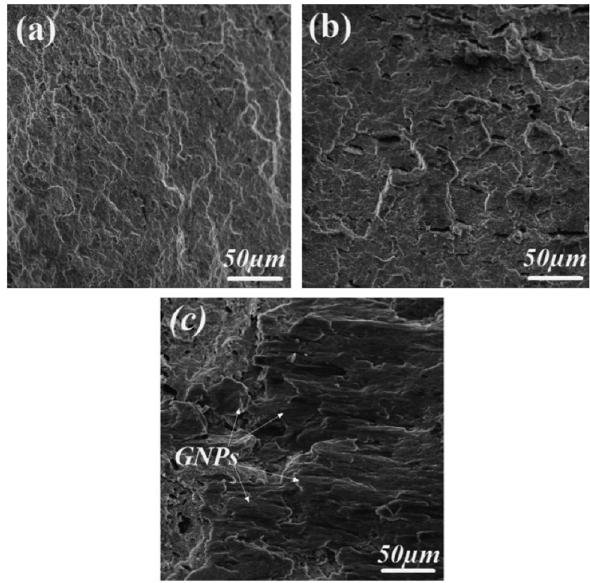
Figure 7: SEM images of fracture surface: ( a ) pure Al, ( b ) 0.3 wt% of GNP/Al, and ( c ) 0.3 wt% of GNP/Al which is perpendicular to the extrusion direction. Reproduced from ref. [ 30 ]